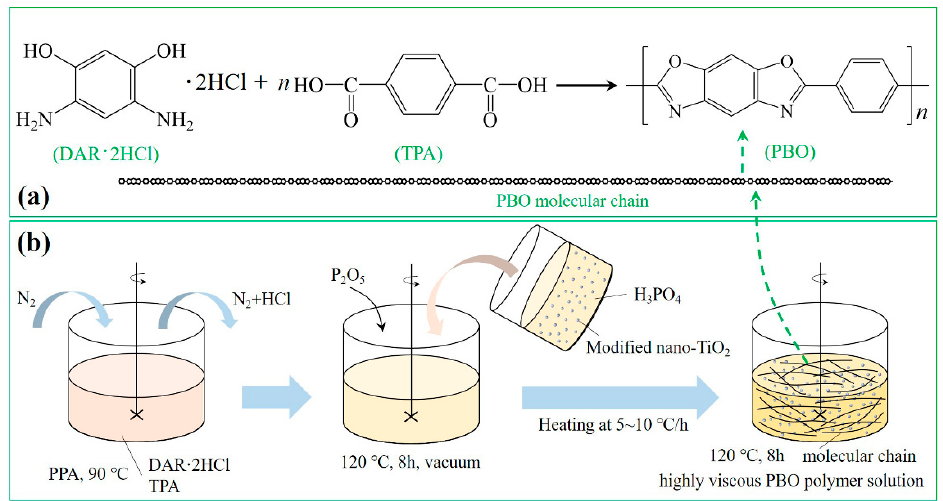
Figure 2. Scheme of PBO preparation ( a ), and procedure of preparing poly(p-phenylene benzobisoxazole) (PBO) polymer solution ( b ).